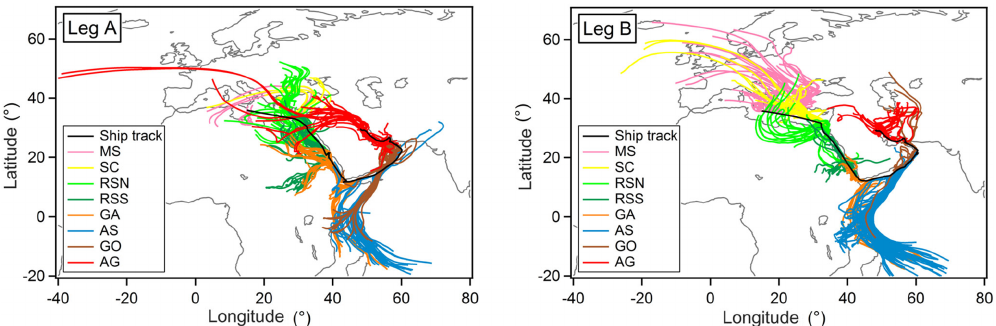
Figure 1. Back-trajectory calculations along the route which start at the ship position and follow air masses back in time for 4 days on an hourly time